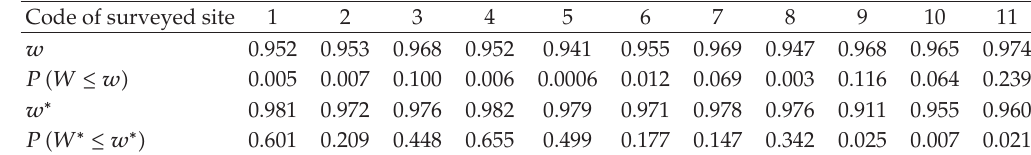
Table 2: Result of headway distribution